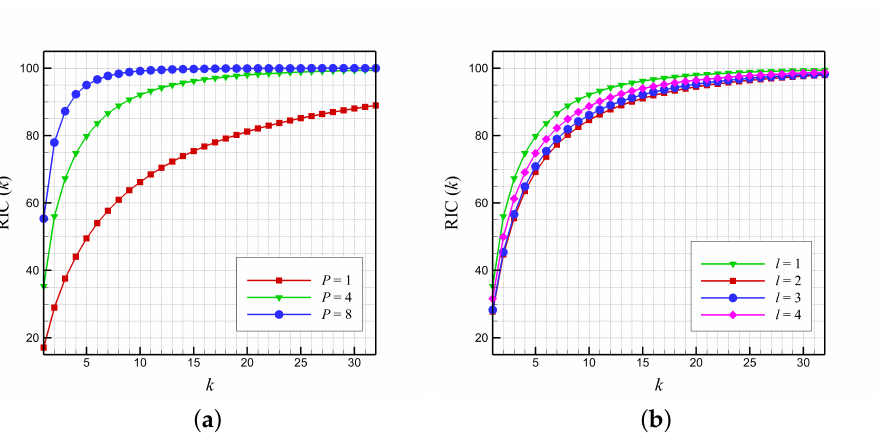
Figure 7. Relative information content (RIC) of the snapshot matrix. ( a ) varying the number of partitions P , and ( b ) its sensitivity with respect to different zones for P = 4